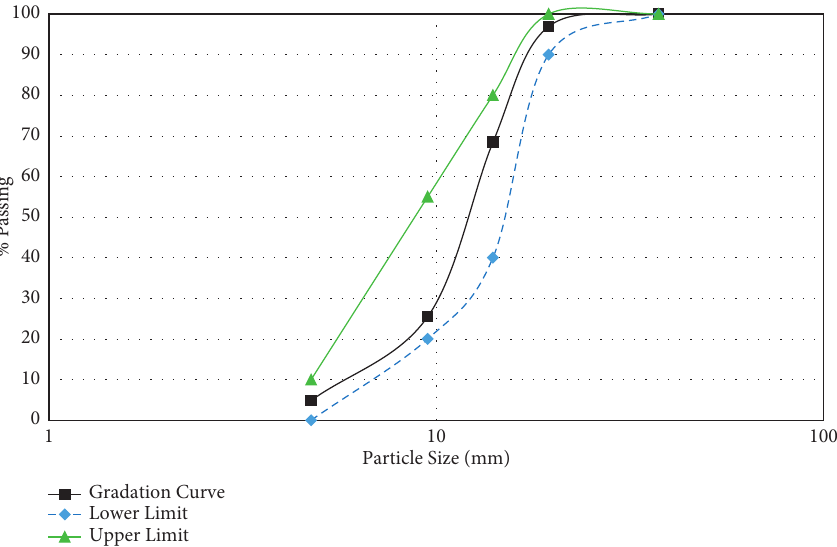
Figure 1: Grading curve of coarse aggregates (CAs).